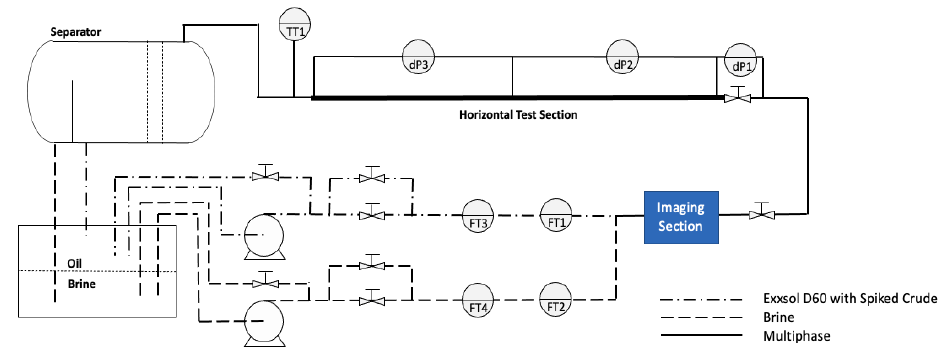
Figure 4. Test mini-loop map.